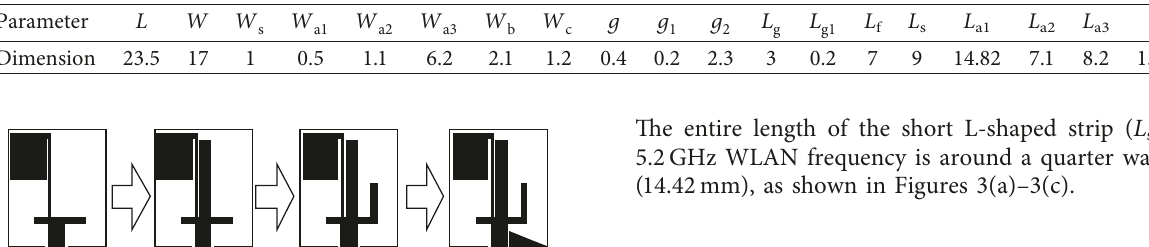
Table 2: The optimal dimensions of the WLAN/WiMAX triband antenna (unit: mm).